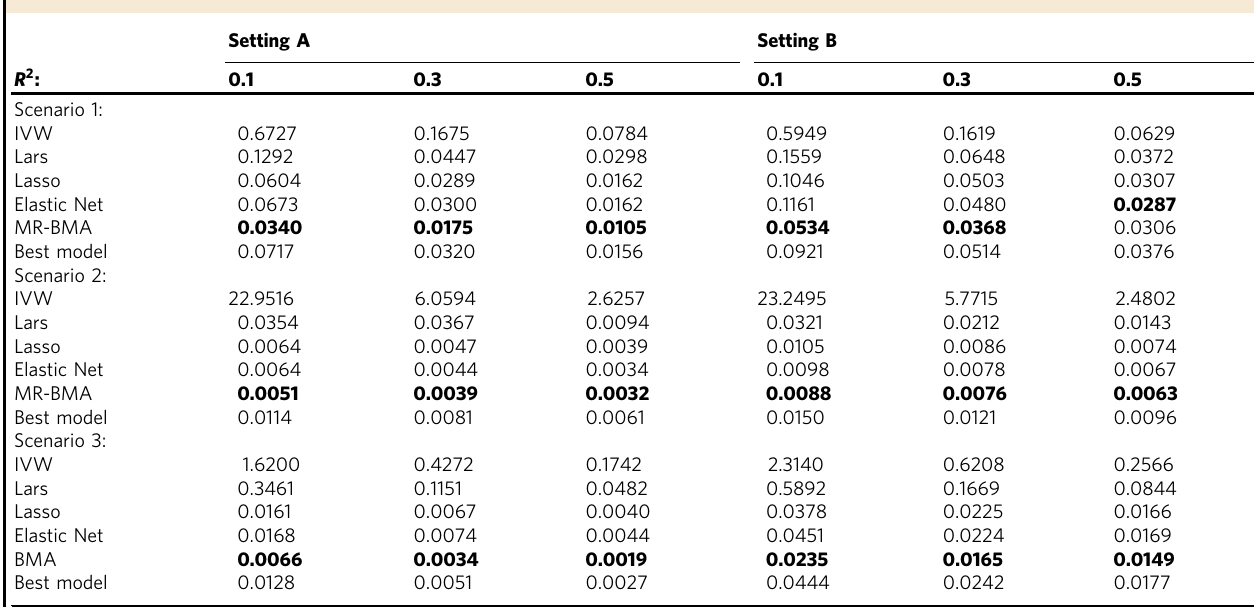
Fig. 3 Receiver operating characteristic (ROC) curve for simulation study on metabolite GWAS. ROC curves plotting the true positive rate against the false positive rate for a a small number of risk factors ð d ¼ 12 Þ of which four have true positive effects (Scenario 1, Setting A) and for b a large number of risk factors ð d ¼ 92 Þ of which four have true positive effects (Scenario 2, Setting A). Proportion of variance explained ( R 2 ) is set to 0.3. Table 1 Mean squared error (MSE) of the causal effect estimates from the competing methods on the NMR metabolite and blood cell trait